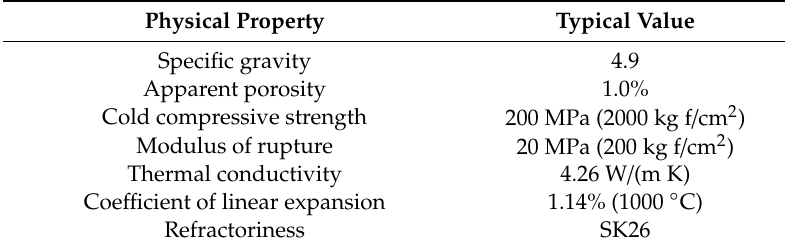
Figure 2. Scanning electron micrographs of Iron (III) oxide raw material ( A ) and fired ceramic ( B ). Table 2. General physical properties of the Iron (III) oxide-based ceramic.